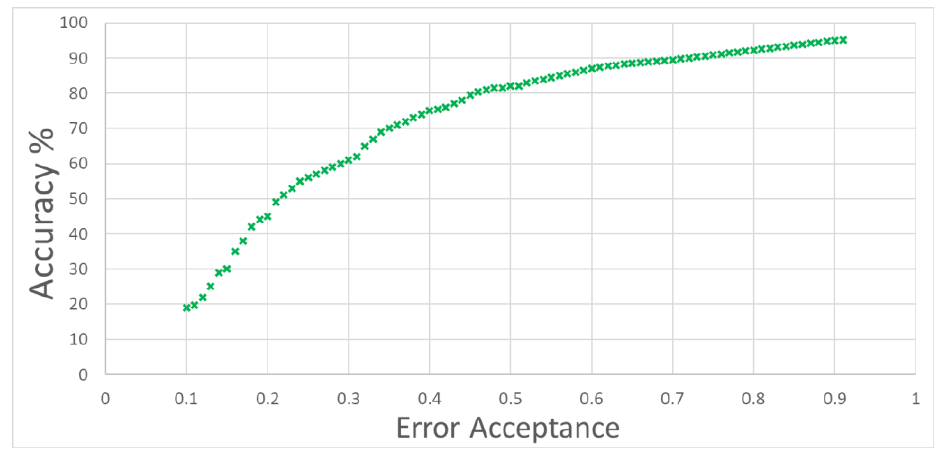
Figure 16. Prediction accuracy of the Bayesian multi-linear regression model under various error acceptance thresholds.